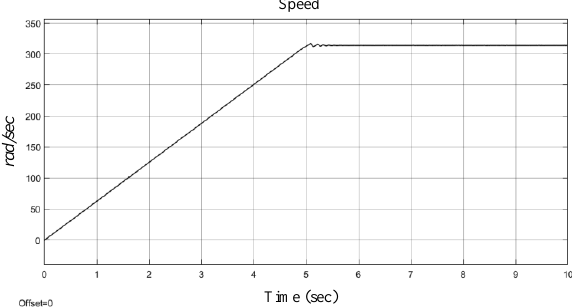
Figure 11. The simulated speed response of speed command of 314 rad/s.